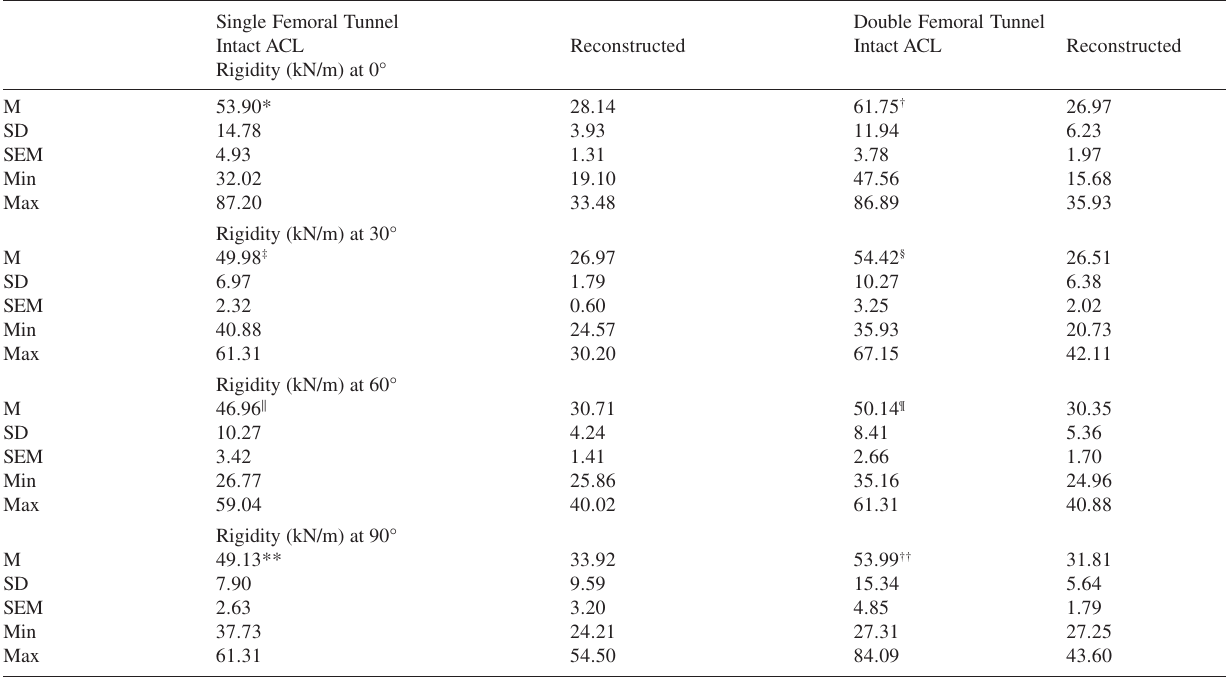
Table 2 - Rigidity at 0°, 30°, 60°, and 90° of flexion in knees subjected to reconstruction with single and double femoral tunnels preceded by their respective controls with intact anterior cruciate ligament (ACL) Single Femoral Tunnel Double Femoral Tunnel Intact ACL Reconstructed Intact ACL Reconstructed Rigidity (kN/m) at